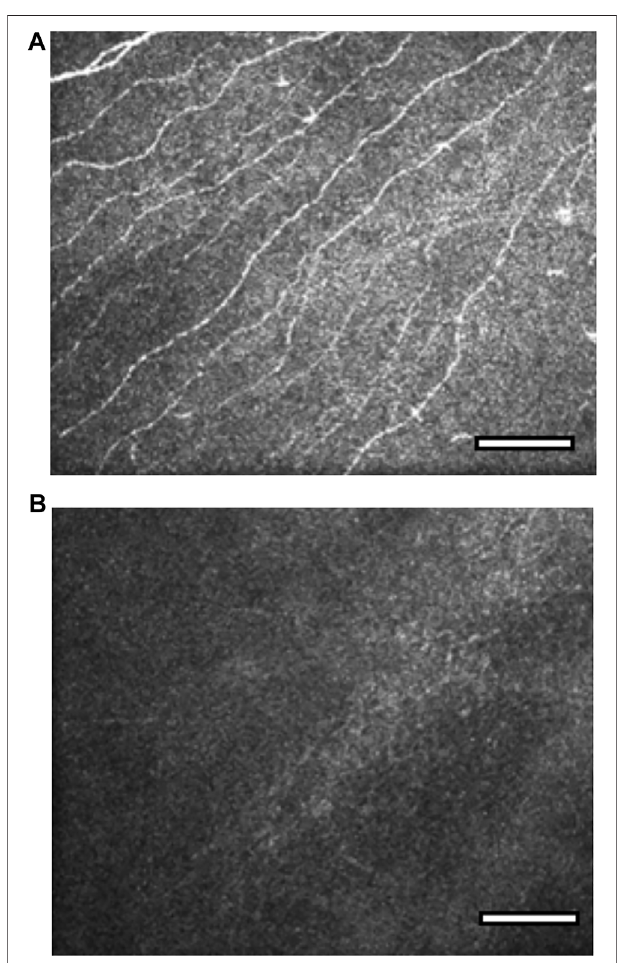
FIGURE 3 | In vivo confocal microscopy images of the sub-basal nerve plexus in congenital corneal anaesthesia (CCA). Reproduced with permission from the British Journal of Ophthalmology and Guillon-Rolf et al. (Guillon-Rolf et al., 2020). Figure 3A . Sub-basal plexus in a normal cornea at depth 50 μ m. Figure3B .Absenceofsub-basalnerveplexusnervesinapatientwith congenital corneal anaesthesia at depth 50 μ